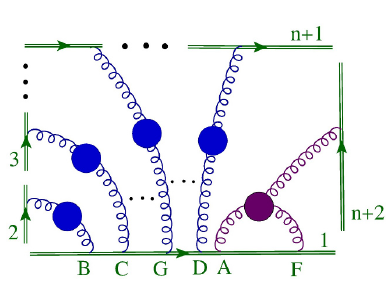
Figure 11. Diagram of the general Cweb W ( n +1)